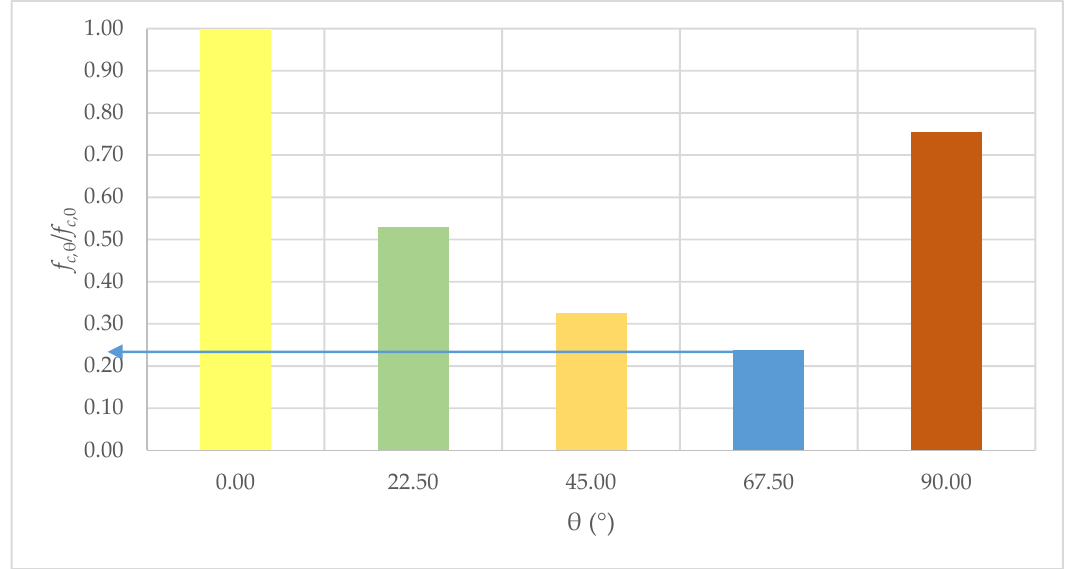
Figure 7. Changes in the compressive strength coefficient f c , θ / f c ,0 in relation to the angle of the bed joints angle θ .